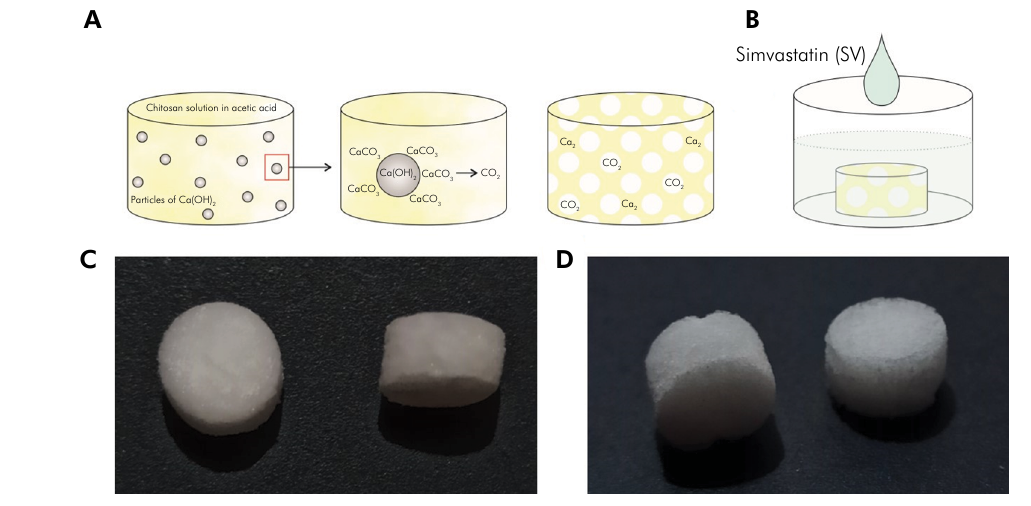
Figure 1. Manufacturing step of scaffolds. (a) Schematic representation of the manufacturing protocol of the CH-Ca Scaffold. particles are incorporated into the chitosan solution in acetic acid, generating their carbonation (CaCO Ca(OH) 2 release of CO , expanding the porous network and complexion of calcium to chitosan; (b) simvastatin (SV) is then incorporated 2 by immersion into the pre-selected concentration in dose- and time-response tests; (c) and (d) are digital images of the CH and CH-Ca scaffolds, respectively, after lyophilization and cross-linking. The spongeous-like architecture obtained is displayed in the